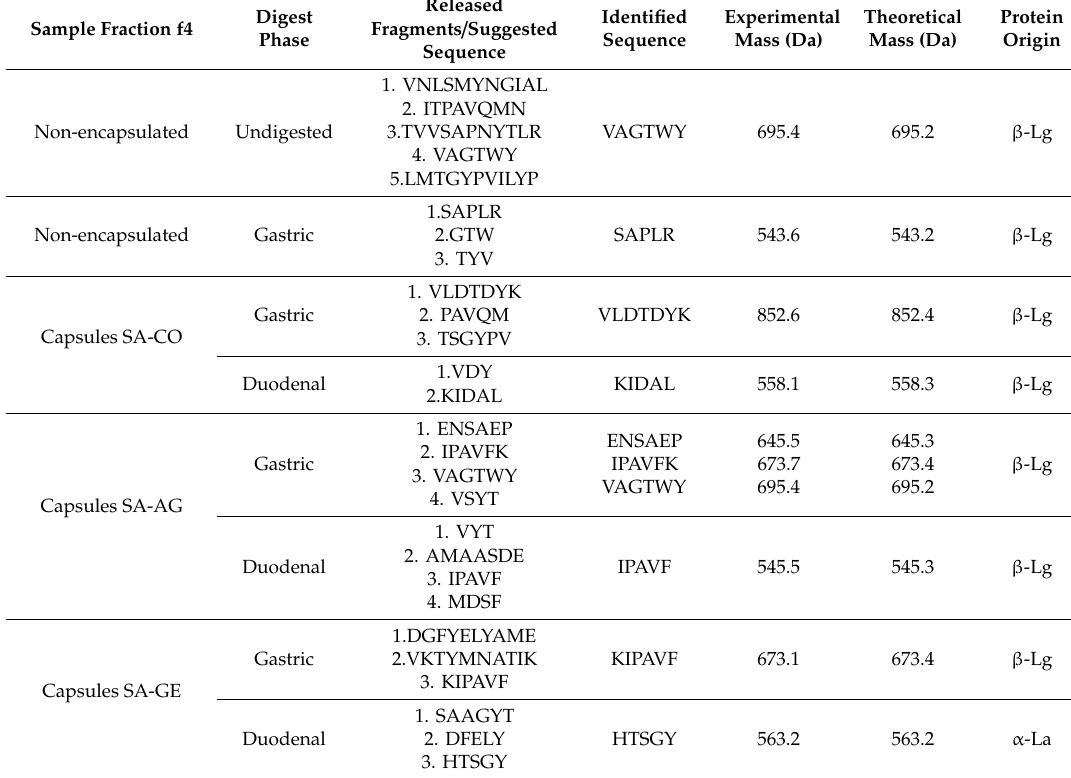
Table 3. Released fragment and identified sequences from fraction f4 during its digestion in simulated